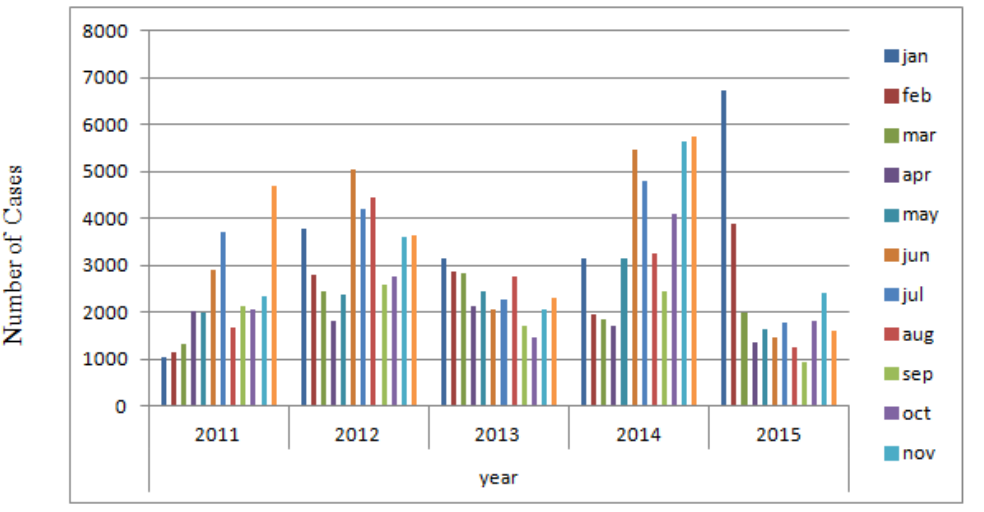
Figure 1: Dengue monthly incidence from 2011 to